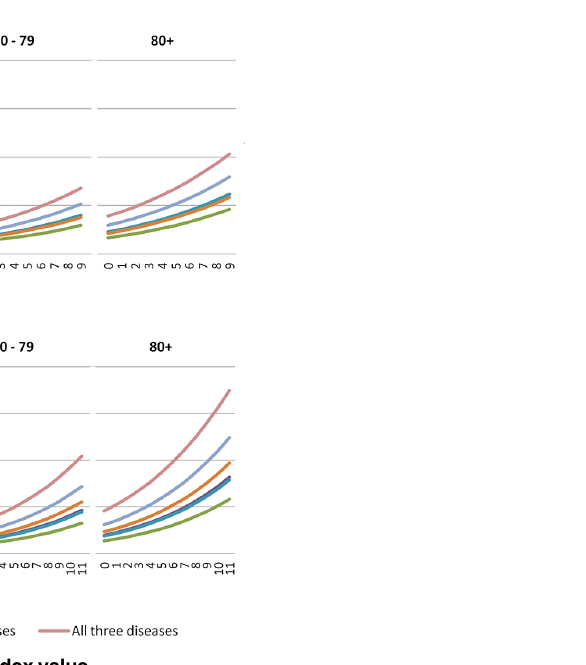
Fig 1. Predicted 5-year risk of stroke by age group and SPoRT behavioural index